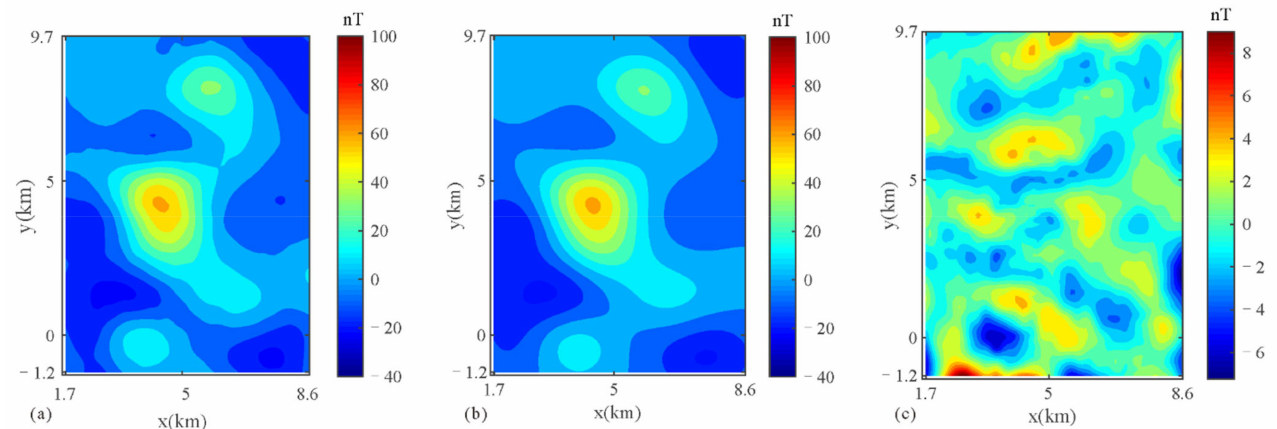
Figure 13. High-value area of magnetite-caused RTP anomaly maps in Pandian Pluton subregion: ( a ) observed data; ( b ) predicted data from the inversion model; ( c ) difference between the observed and predicted data.